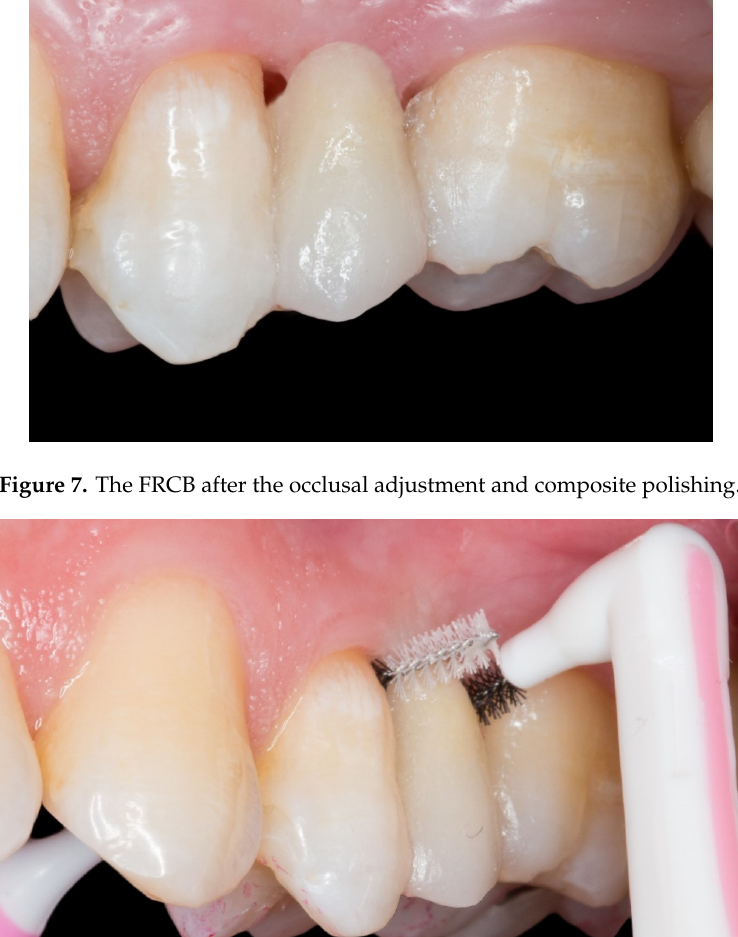
Figure 8. The embrasures are released allowing adequate interproximal brushing, avoiding periodontal disease and interproximal caries.